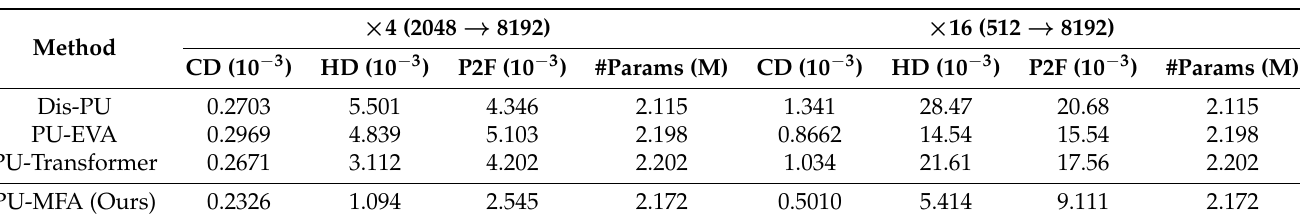
Table 2. Comparing the quantitative evaluation of × 4 and × 16 up-sampling with the state-of-the- art methods.